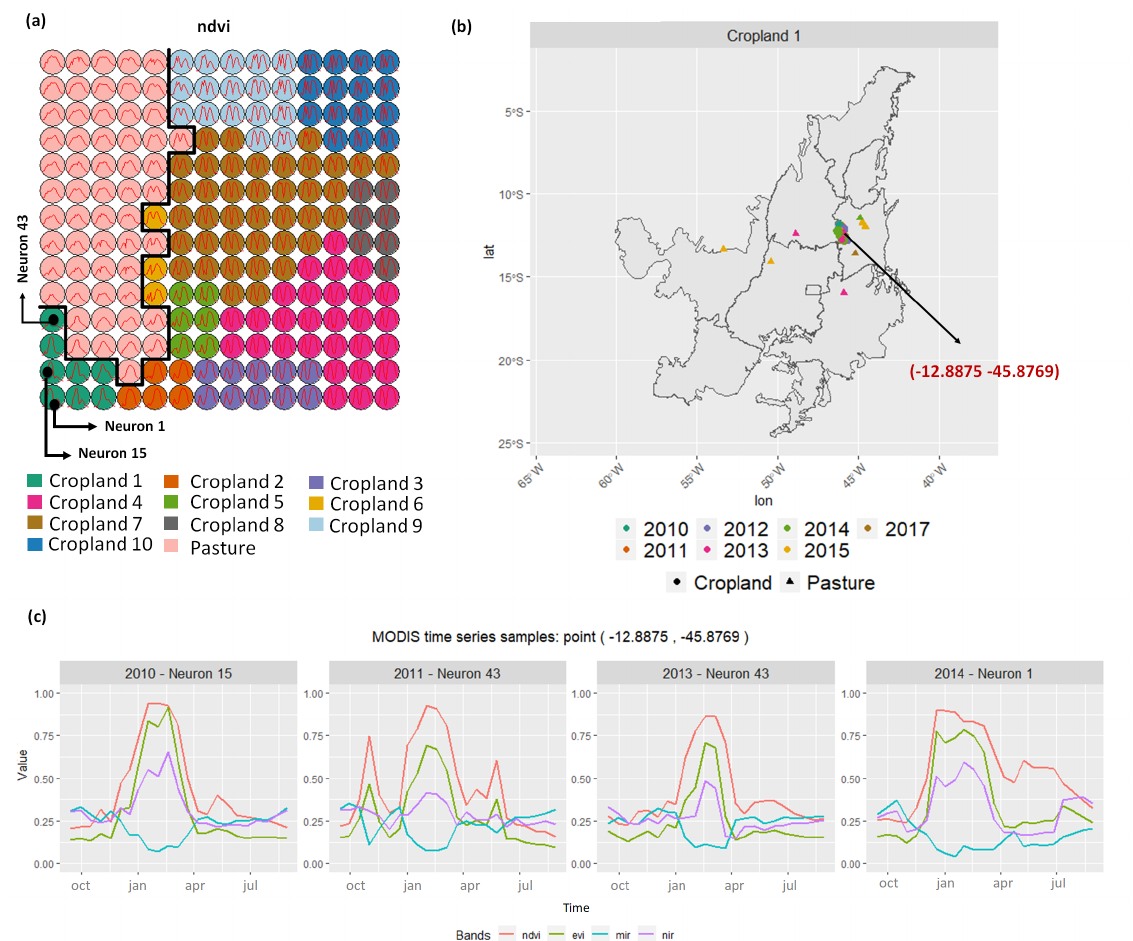
Figure 9. The cluster of soy–fallow: subclusters of Cropland 1. ( a ) SOM grid with soy–fallow subclusters. ( b ) The spatial location where the samples assigned to Cropland 1 are. ( c ) Changes in Moderate Resolution Imaging Spectroradiomet (MODIS) time series of point ( − 12.8875, − 45.8769) over 4